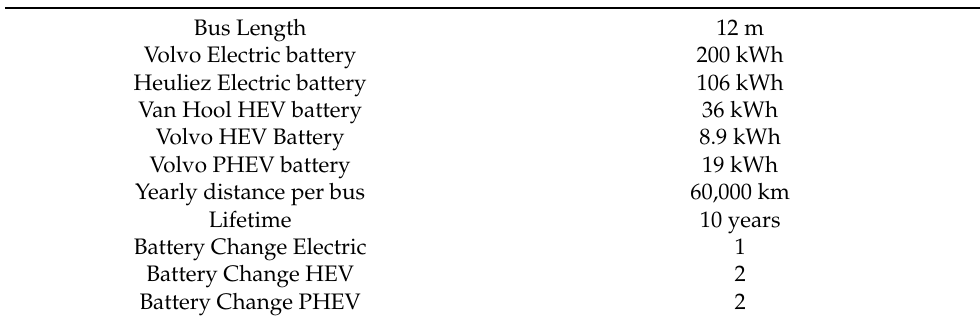
Table 5. Case study